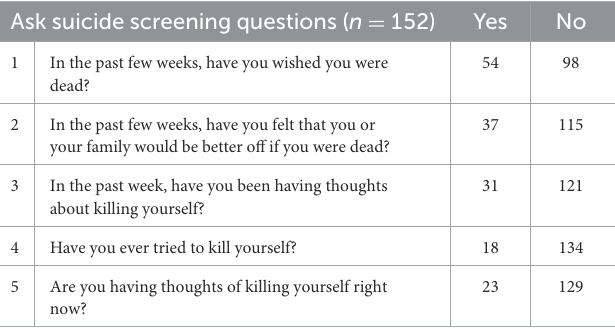
TABLE 5 Screening of patients using the Ask Suicide Screening Questionnaire for suicidal ideation among depressed patients. Ask suicide screening questions ( n =